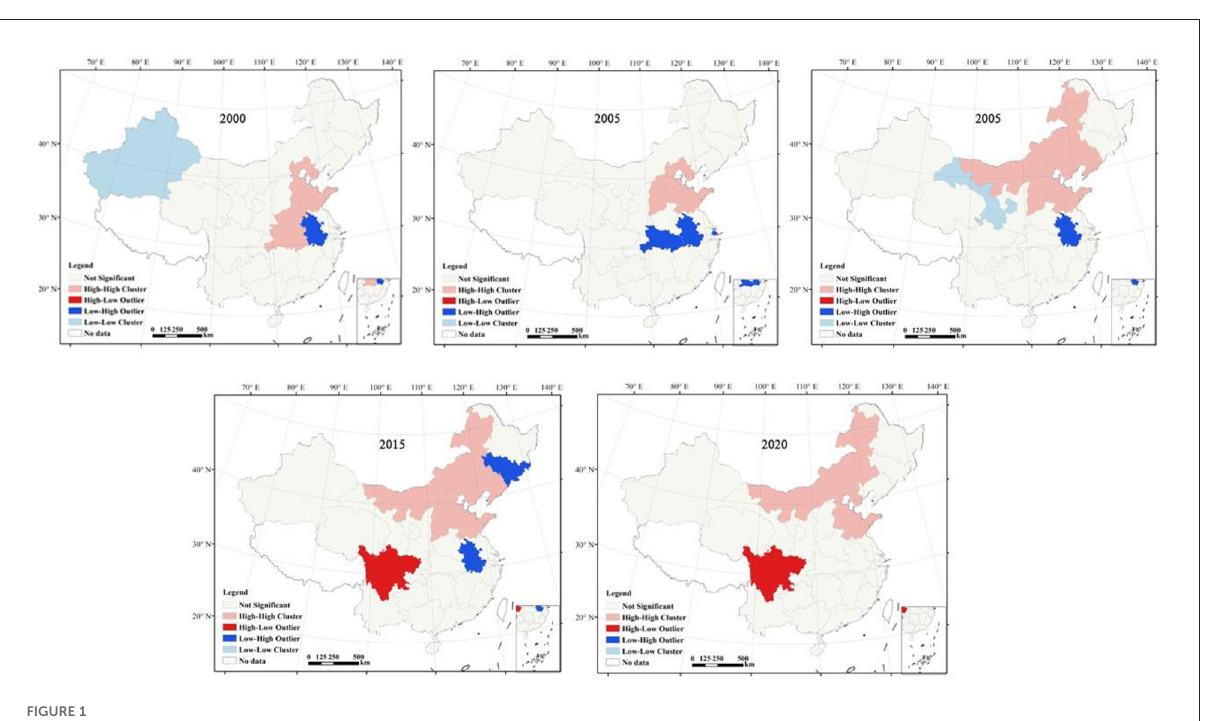
Trend analysis Trend analysis of core explanatory variables The spatial distribution direction and dynamic characteristics of the comprehensive EP at the national and provincial scales were investigated using the standard deviation ellipse analysis tool of ArcGIS 10.3 software